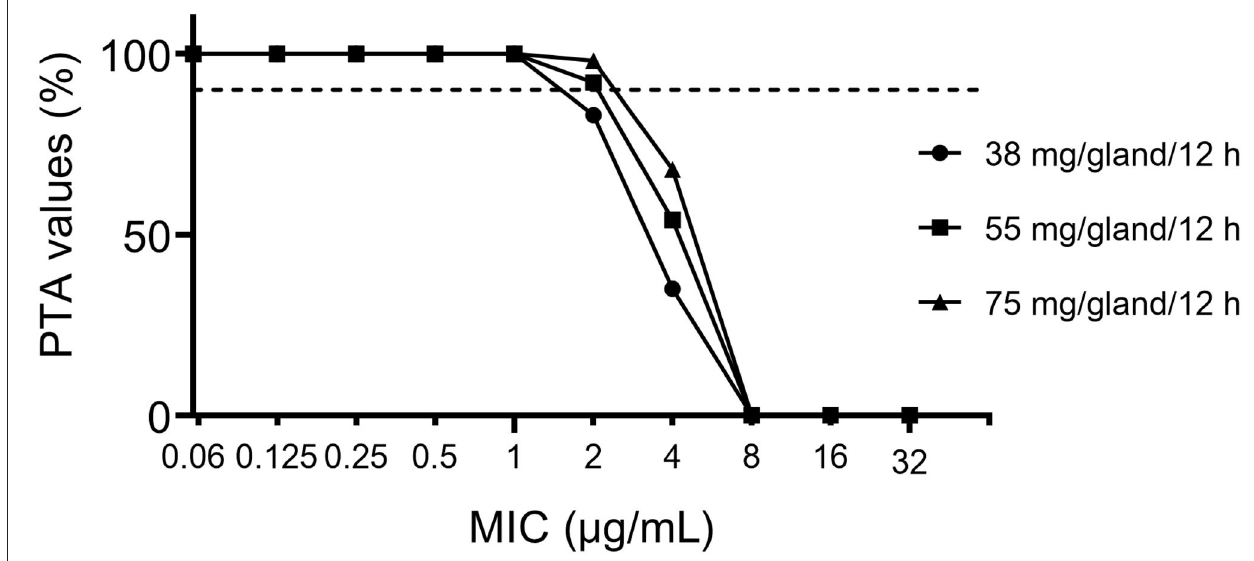
FIGURE 5 | Probability of target attainment (PTA) of cefquinome against bovine mastitis caused by S. aureus at the dose of 38, 55, 75